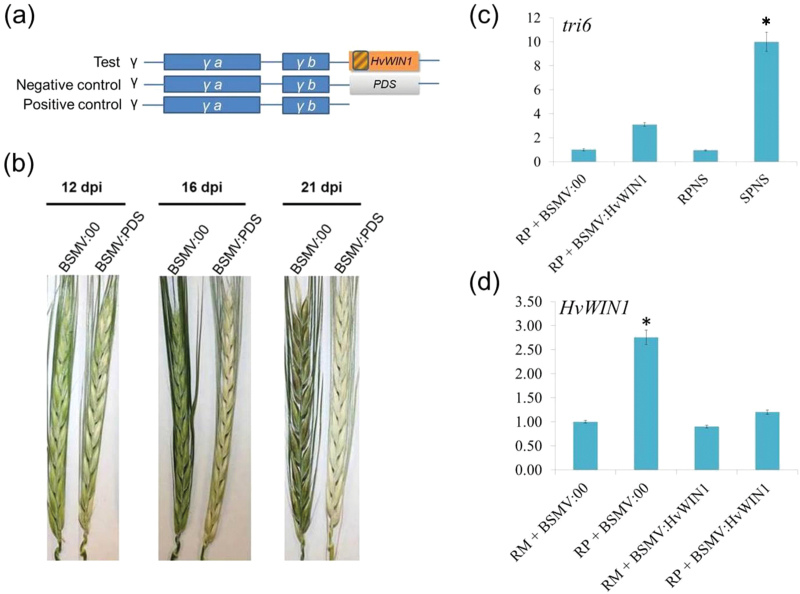
Virus-induced gene silencing of HvWIN1. (A) Schematic representation of BSMV-based virus-induced gene silencing (VIGS) vectors. The HvWIN1 cDNA fragment was cloned to pSL038-1 vector (modified BSMV vector) downstream of the γb gene (BSMV:HvWIN1). The vector carrying either the phytoene desaturase (PDS) gene (BSMV:PDS) or without any plant gene (BSMV:00) served as positive control and negative control, respectively. The region in the HvWIN1 with gradient fill depicts the part of the gene used for silencing. (B) Phenotypes of the spikes from barley cultivar CI9831 rub-inoculated with either BSMV:PDS or BSMV:00 constructs. Spikes were rub-inoculated with either BSMV:00 (negative control) or BSMV:PDS (positive control) constructs at flag leaf stage and photographed at different time intervals. dpi, days post rub-inoculation. (C) Relative fungal biomass calculated as relative gene copy number of tri6 at 6 dpi. (D) Relative transcript expression measured at 72 hpi. RM, mock-treated resistant samples; RP, pathogen-treated resistant samples; BSMV:00, barley plants rub-inoculated with negative control; BSMV:HvWIN1, barley plants rub-inoculated with BSMV vector containing HvWIN1. Significant differences in expression levels in RP+BSMV:00 compared with RP+BSMV:HvWIN1 using student’s t-test: *, P<0.05. A colour version of this figure is available at JXB online.